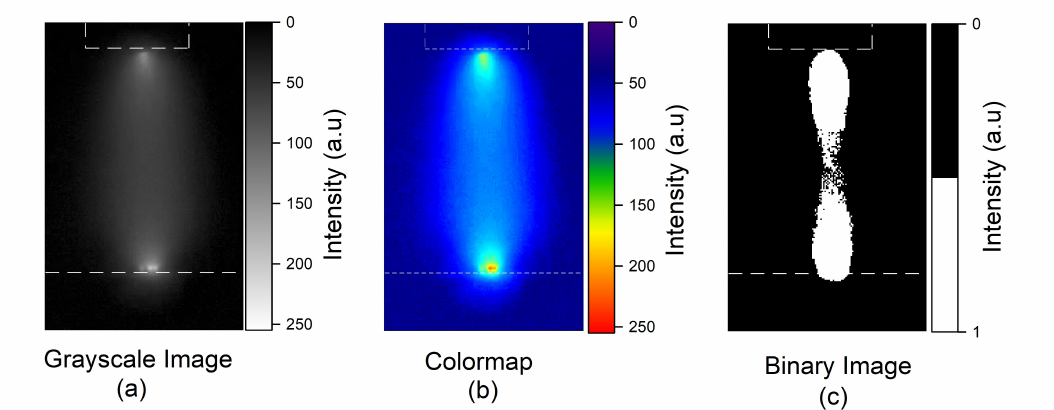
Figure 6. Intensity distribution in a.u (arbitrary unit) of arc image in ( a ) grayscale image and ( b ) colormap ( c ); binary converted image with threshold = 80.